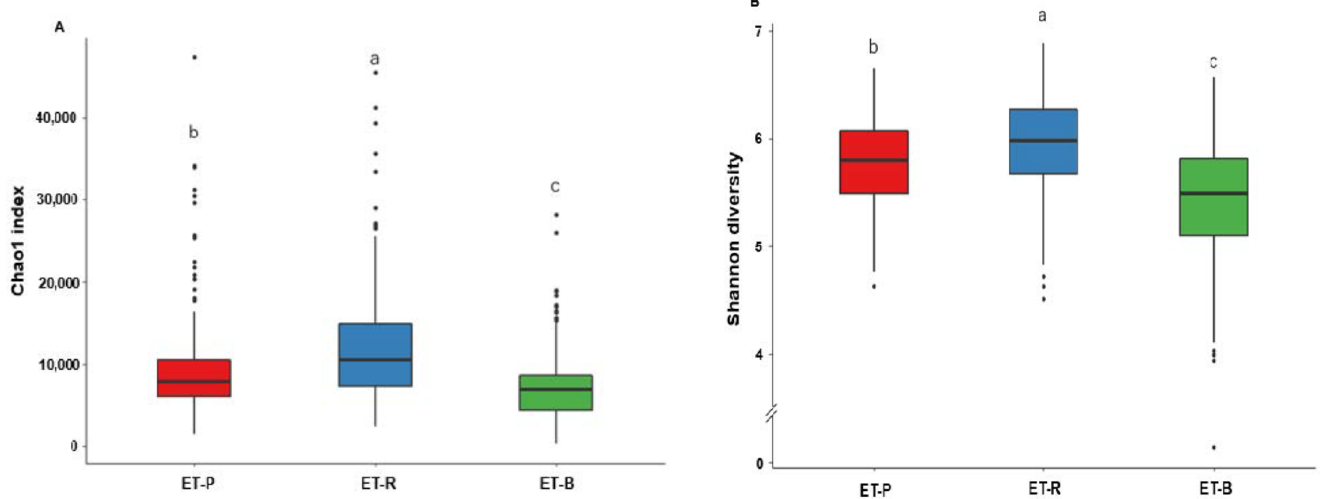
Figure 4. Alpha diversity in different enterotypes. ( A ) Chao1 index. ( B ) Shannon diversity. Different alphabets (a,b,c) represented significant differences among the different bacteria in the family level by Tukey’s test at p < 0.05. ET-P, Prevotellaceae ; ET-R, Ruminococcaceae ; ET-B, Bacteroidaceae .